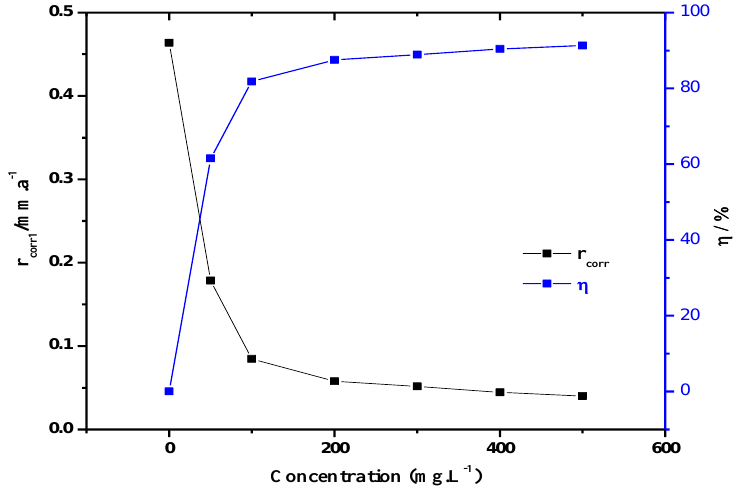
Figure 3. Effect of the dosage of MBT on the corrosion rate and corrosion inhibition rate of the N80 steel sheet.